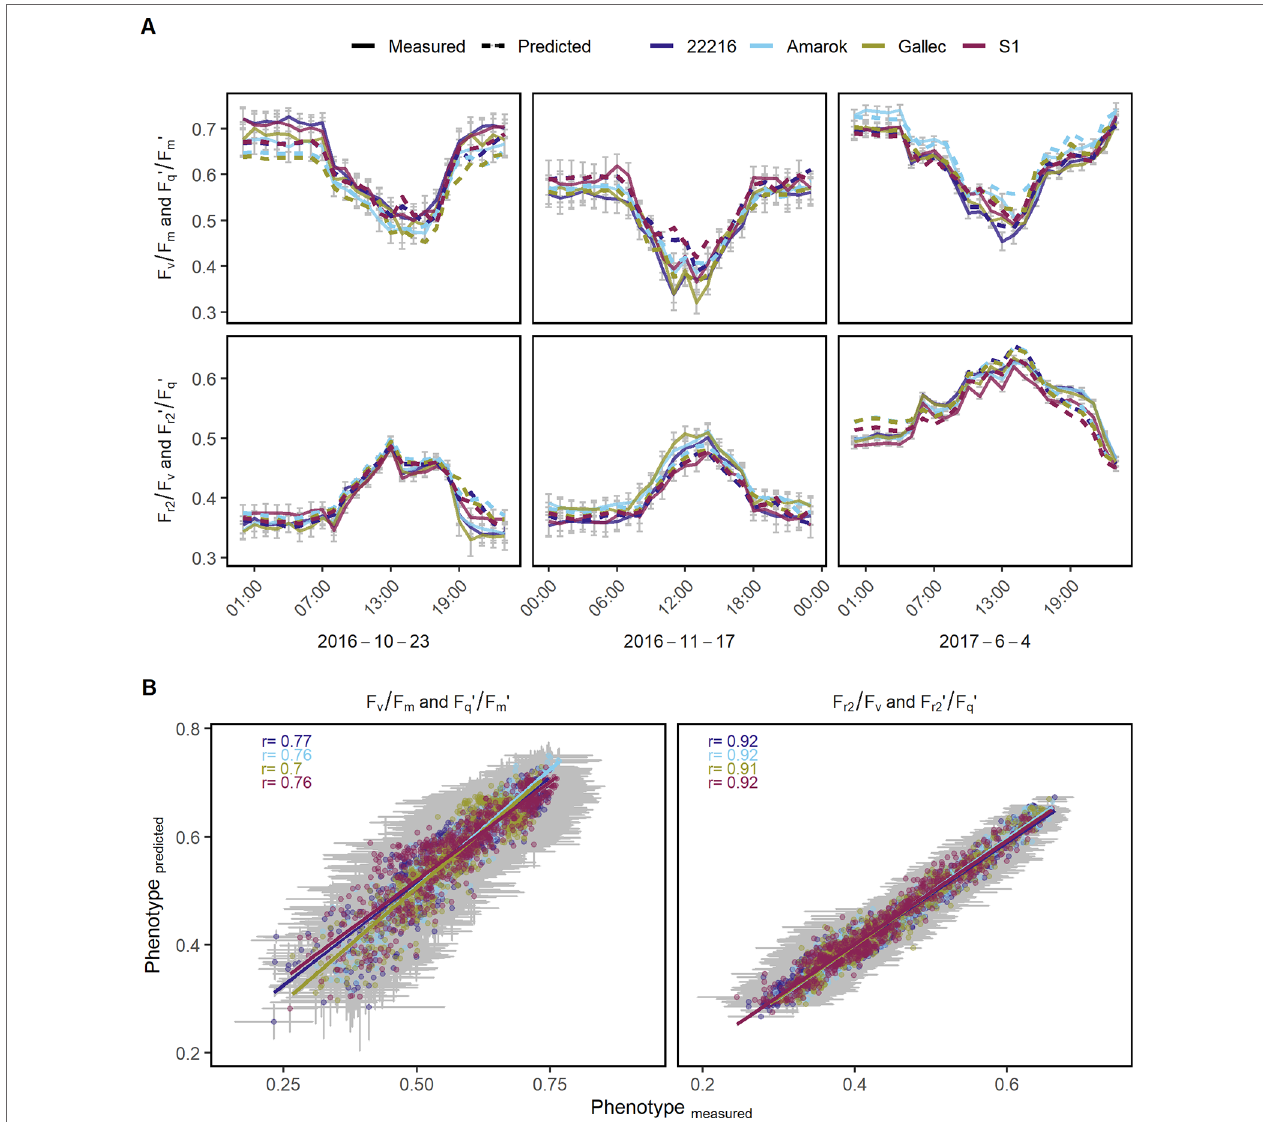
FIGURE 6 | Chlorophyll fluorescence parameters were used to model genotype x environment interactions of different soybean genotypes. (A) Quantum efficiency of the photosystem II (F v /F m in the dark and F q '/F m ' in the light) and the efficiency of electron transport 5 ms after reduction of primary quinone (Q A ) (F r2 /F v in the dark, F r2 '/F q ' in the light) at three random dates with measured (full line) and modeled (dashed line) values are shown. (B) Predicted and measured values for both photosynthetic parameters were correlated to each other in order to assess the model accuracy. Measurements of 48 days were used to train the model using Lasso regression (n = 284,662). Photosynthetic performance over the remaining 47 days was predicted and validated (n = 295,885). Predicted and measured values were averaged per genotype, day and hour. Error bars show the 95% confidence interval. The λ value derived through internal cross-validation on the training set was 1.14285 x 10 −5 and 3.626669 x 10 −5 for F v /F m and F r2 /F v , respectively. For the Lasso model coefficients see Supplementary Table 4